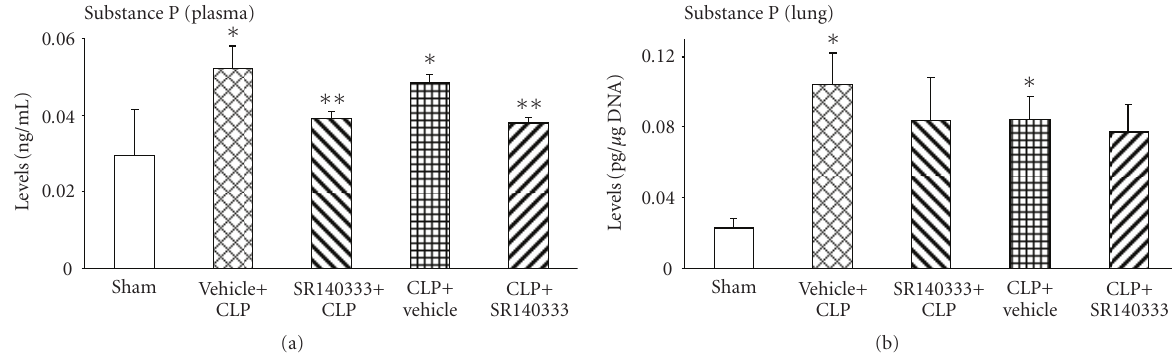
Figure 5: E ff ect of SR140333 administration, either 30 minutes before or 1 hour after CLP, on (a) plasma and (b) lung SP levels. Results shown are the mean ± S.E.M ( n = 6–9 in each group). “Vehicle + CLP” and “SR140333 + CLP” represent the groups that received vehicle and SR140333 treatment, respectively, commencing 30 minutes prior to CLP. “CLP + vehicle” and “CLP + SR140333” represent the groups that received vehicle and SR140333 treatment, respectively, 1 hour after CLP. ∗ P < . 01 when vehicle-treated CLP animals were compared with sham group animals; ∗∗ P < . 05 when SR140333-treated CLP animals were compared with vehicle-treated CLP animals. CLP: cecal ligation and puncture; SP: substance P